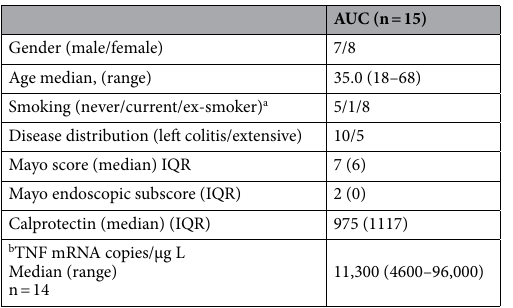
Table 1. Treatment naive acute ulcerative colitis (AUC). a 1 unknown. b 1 TNF value from baseline characteristics